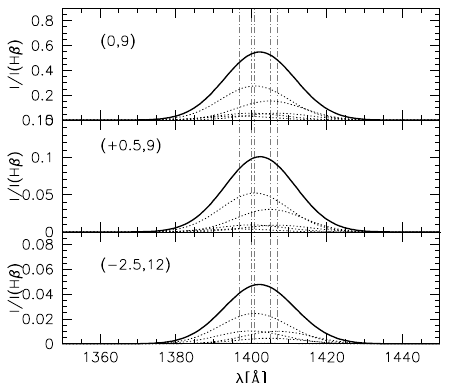
Figure 10. Composite O IV ] λ 1402 profile (thick line), with the individual components of the